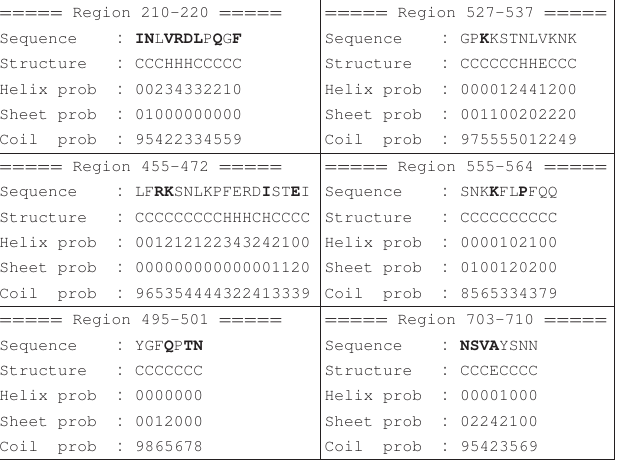
TABLE 1 | Secondary structure propensity of the reported regions evaluated by using the PEP2D server (Singh et al., 2019). ===== Region 210-220 ===== ===== Region 527-537